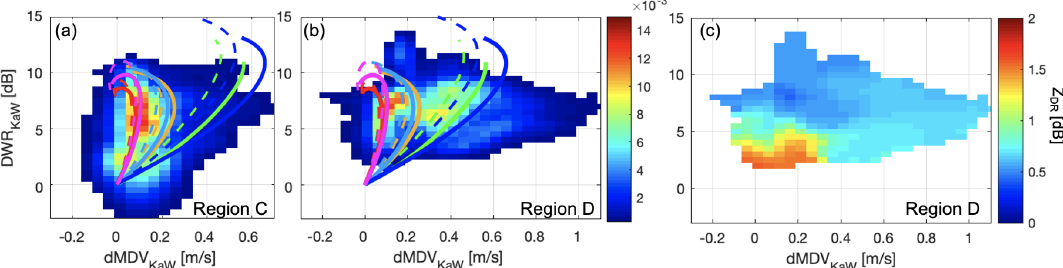
Figure 10. Difference in KASPR VPT MDV versus DWR KaW and ROGER MDV versus DWR KaW diagrams for (a) Region C and (b) Region D. Color shades represent normalized frequency. Panel (c) is the same as (b) , but the color shades represent KASPR QVP Z DR . Lines in panels (a) and (b) represent the SSRGA calculations using particle type and PSD models described in Appendix A. The legend for the lines is the same as in Fig. 1.